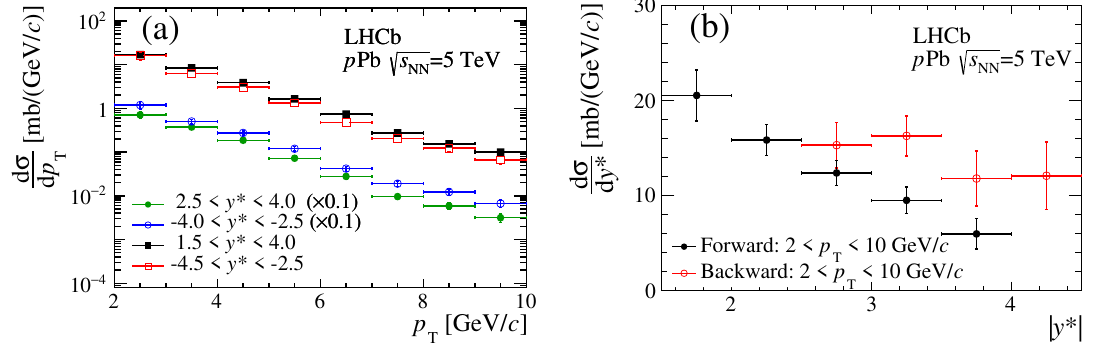
Figure 4 . Di(cid:11)erential cross-section of prompt (cid:3) + baryons in p Pb collisions as a function of (a) p T c and (b) y (cid:3) in the forward and backward samples. The forward and backward di(cid:11)erential cross- sections d (cid:27)= d p T in the common rapidity region 2 : 5 < j y (cid:3) j < 4 : 0 are scaled by 0.1 to improve the visibility. The box on each point represents the systematic uncertainty and the error bar represents the sum in quadrature of the statistical and the systematic